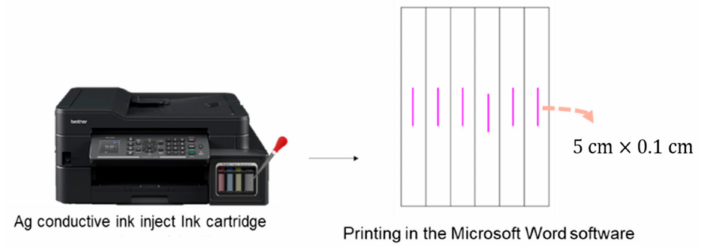
Figure 1. The schematic diagram of printing conductive pattern.